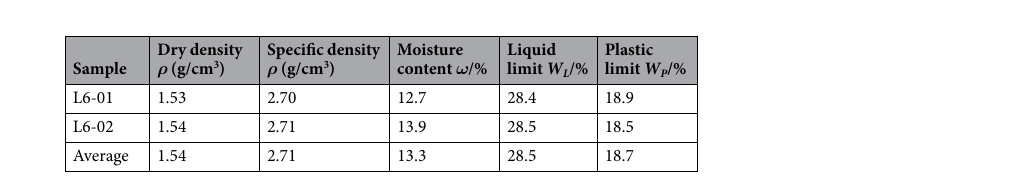
Table 5. Physical properties of the intact loess